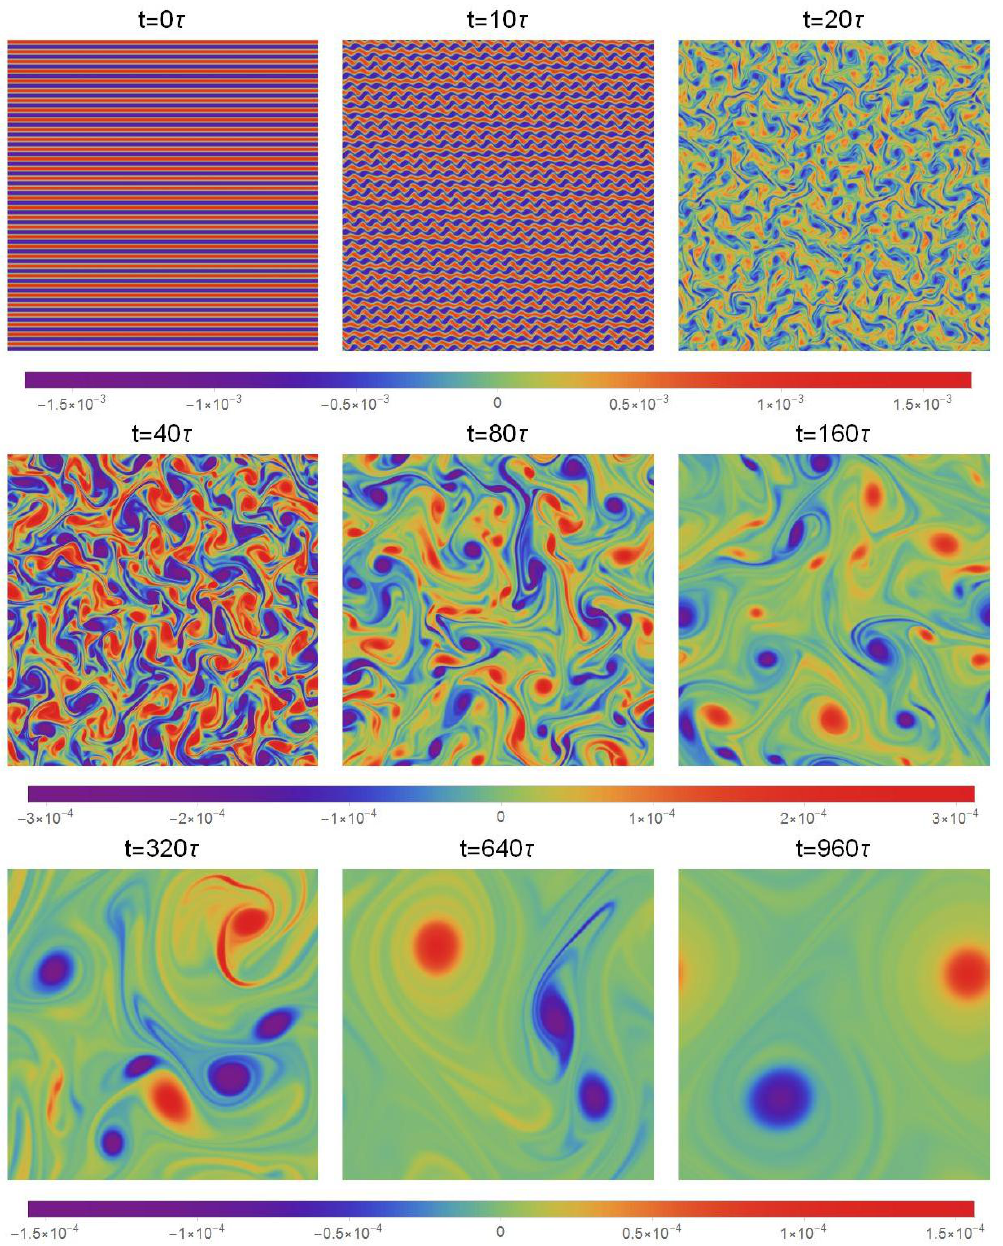
Figure 1 . The vorticity (cid:12)eld ! = @ x u y (cid:0) @ y u x of a two dimensional turbulent regime with initial Reynolds number Re = 1562 : 5, Mach number M = 0 : 5, initial mode n = 32, and noise scale A = 10 (cid:0) 5 at various times. The instability becomes apparent around t (cid:25) 10 (cid:28) , followed by a chaotic behavior generating small eddies shown at t = 20 (cid:28) . The inverse cascade is apparent in the \merging" of co-rotating eddies to form larger ones starting around t (cid:25) 20 (cid:28) and ending at t (cid:25) 960 (cid:28) . The termination of the inverse cascade is caused by the (cid:12)nite length of the box. The (cid:12)nal stage shown at t = 960 (cid:28) is of slow decay of two counter rotating eddies.